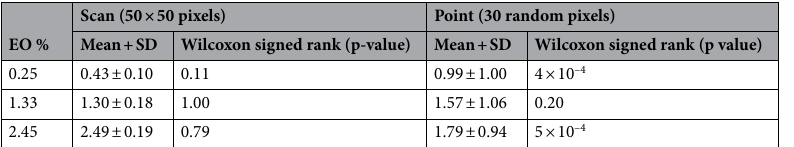
Table 3. EO predictions of 3 spearmint samples with 0.25%, 1.33% and 2.45% EO respectively, predicted based on spectral data collected by Scan (50 × 50) pixels and by point picking of 30 random